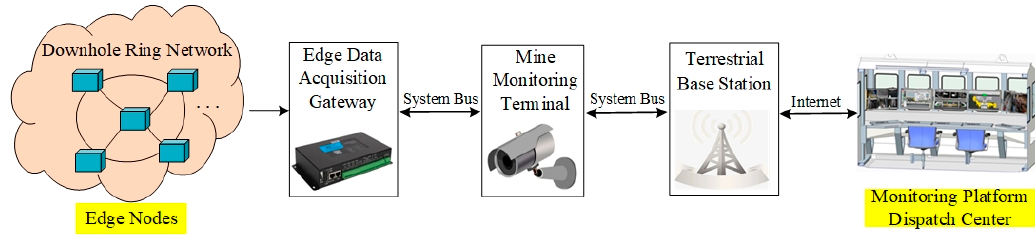
Figure 1. Overall architecture of mine monitoring system.